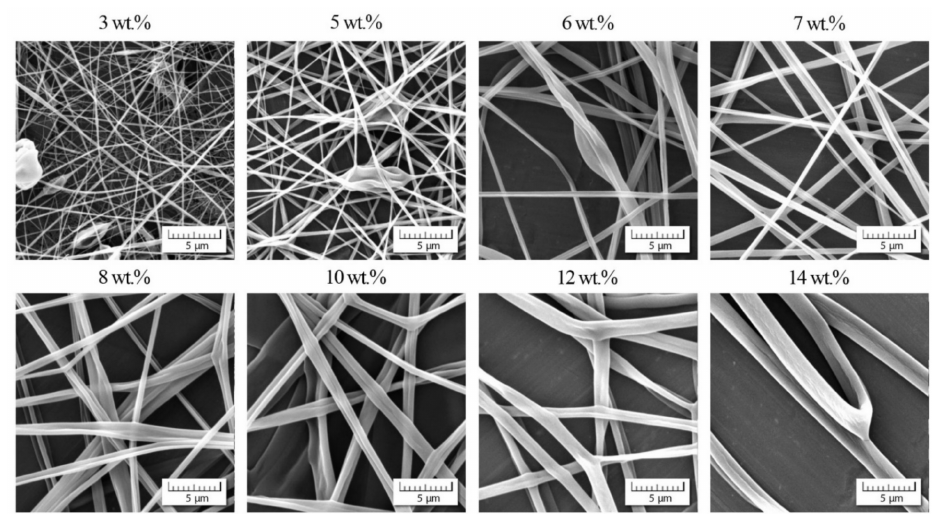
Figure 5. Morphology of individual nanofibers in dependence on PVB concentration.